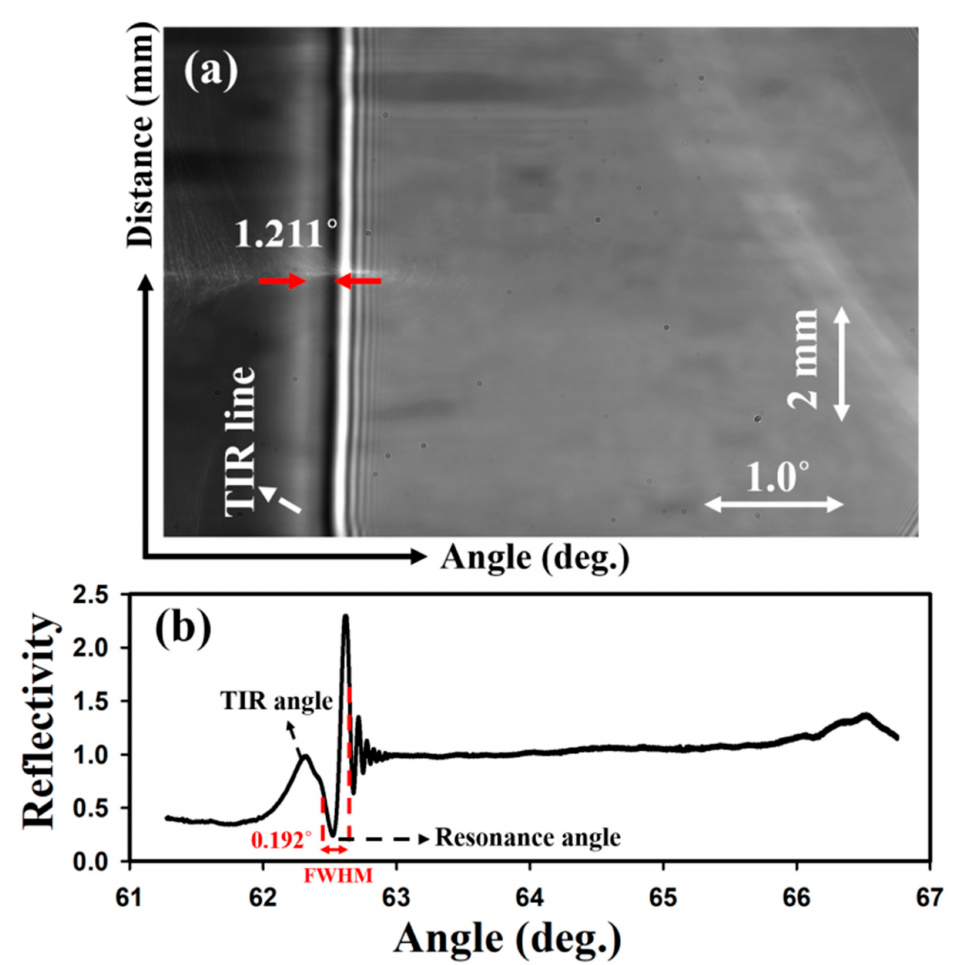
Figure 2. ( a ) Output of a chitosan LW with flow cell mounted on the top and filled with HEPES bu ff er, and ( b ) the corresponding reflectivity curve (where angle is θ ext as marked in Figure